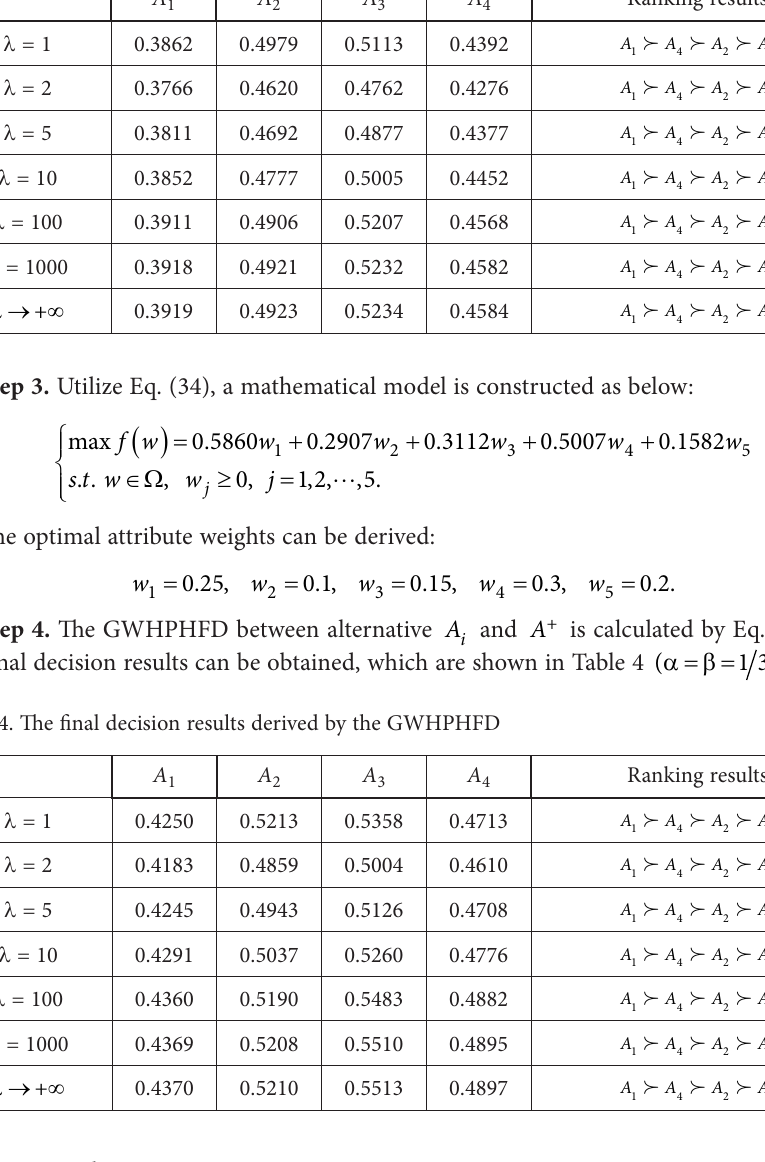
Table 3. The ranking results derived by the GWHPHFD A 1 A 2 A 3 A 4 Ranking results l = 1